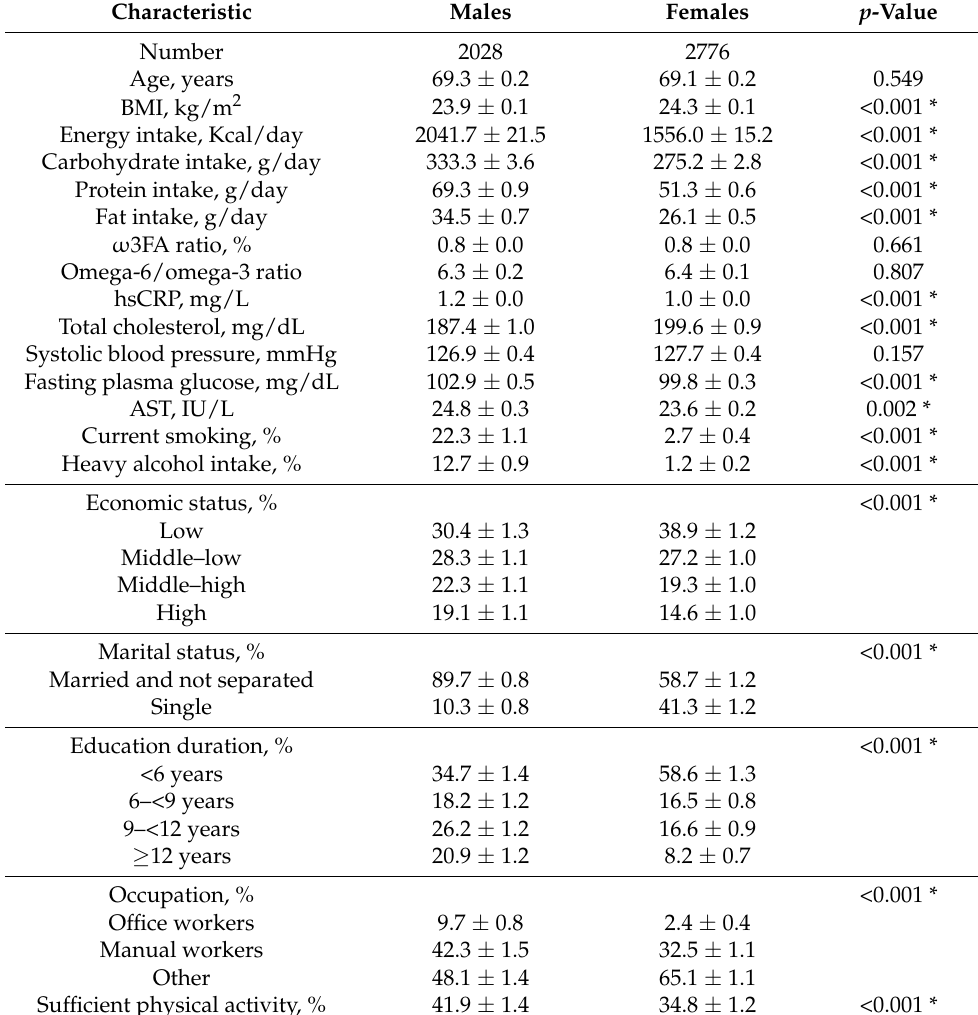
Table 1. Population characteristics according to